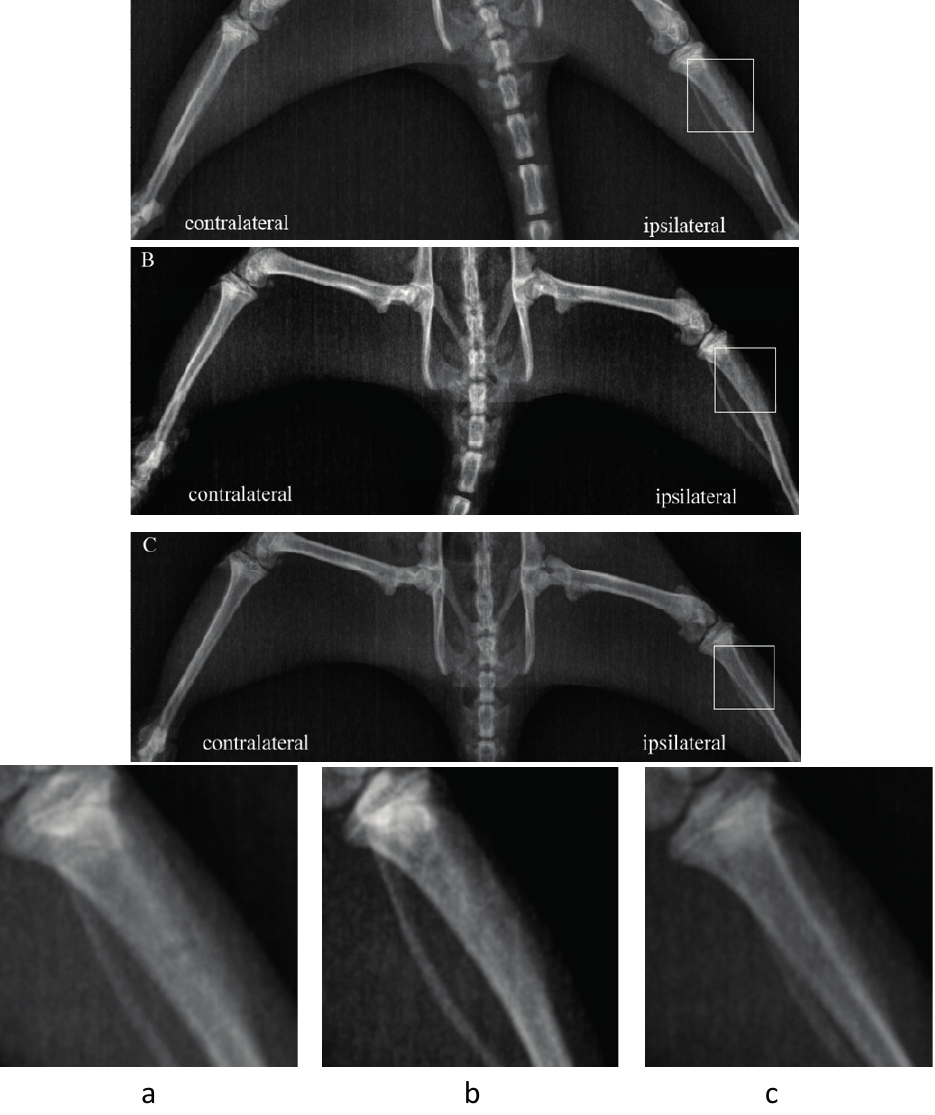
Figure 1. Radiological images of bone cancer-bearing tibiae of rat. ( A ) 7 days after implantation of walker 256 cells, obvious periosteal reaction was detected; ( B ) On day 21 after tumor implantation, significant cortical bone defect was observed in the cell-inoculated tibia bone; and ( C ) There were no radiological changes were observed in the ipsilateral tibia bone following culture media injection on day 21. ( a – c ) showing the proximal end of the ipsilateral tibia bones ( A – C ) with a higher magnification. No radiological changes were observed in the contralateral tibia bone. The white box indicates the injection site.